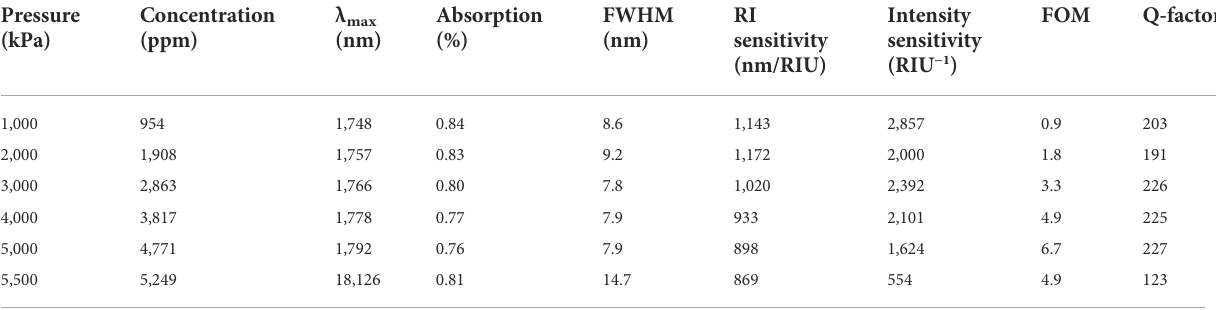
TABLE 4 CO 2 pressure, concentration, peak wavelength, absorption, FWHM, RI sensitivity, intensity sensitivity, FOM, and Q-factor for group G2. Pressure (kPa)